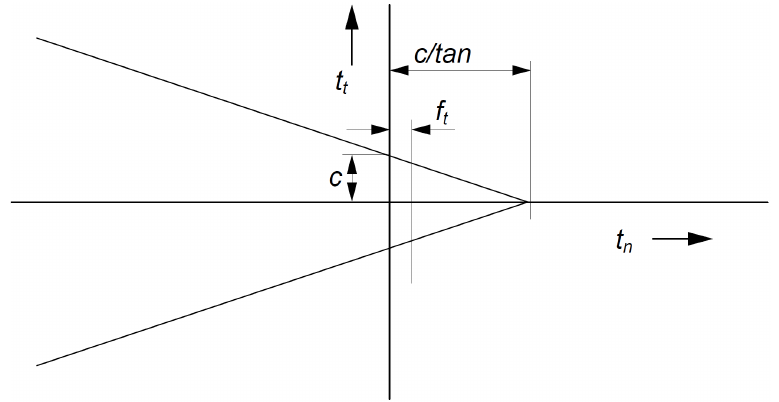
Figure 10. The concept of the Coulomb friction model.